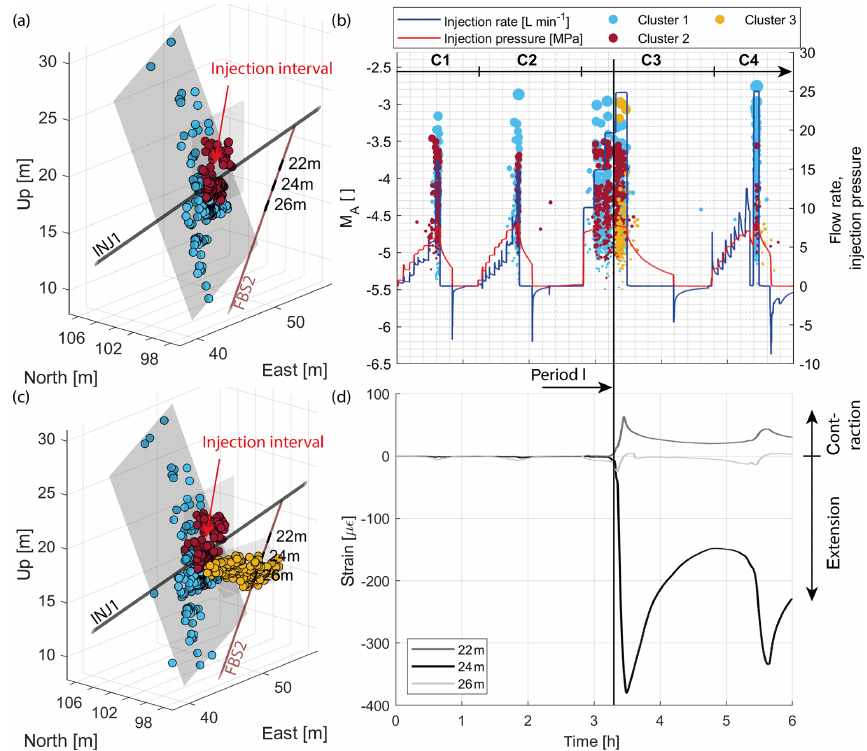
Figure 8. Observation of newly formed fracture during injection experiment HS4. (a) The spatial distribution of seismicity clusters observed during period I, color coded according to cluster affiliation, along with injection borehole INJ1 and the strain-monitoring intervals at 22, 24, and 26m in the strain-monitoring borehole FBS1. (b) The temporal evolution of seismicity including injection parameters. (c) Spatial distribution of all seismicity of the three main clusters. (d) The strain evolution of strain-monitoring intervals at the specified